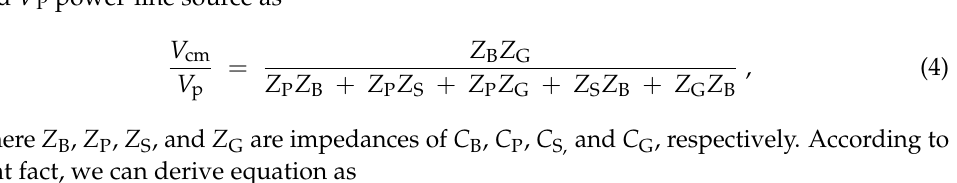
Figure 6. Schematic circuit ( a ) and equivalent circuit for a common-mode voltage ( b ). Based on the model, we can define the ratio between the V cm common-mode